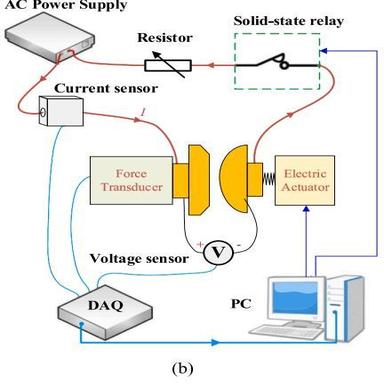
Schematic of the experimental system. (a) Test rig (1—Stepping motor, 2—Electric slider, 3—Ring illuminator, 4—CCD camera (scanning system 1), 5—3D optical surface profiling (scanning system 1), 6—Spring, 7—Electric actuator, 8—Movable electrode, 9—Stationary electrode, 10—Dynamic force transducer, 11—Scanning system 2, 12—Electrode pairs switching position, 13—3D measurement position, 14—2D measurement position.). (b) Experimental circuit.